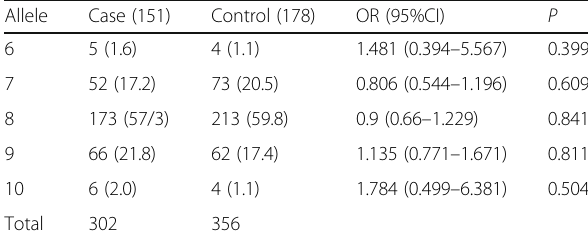
Table 2 The different allele frequencies of the p53 gene between cases and controls